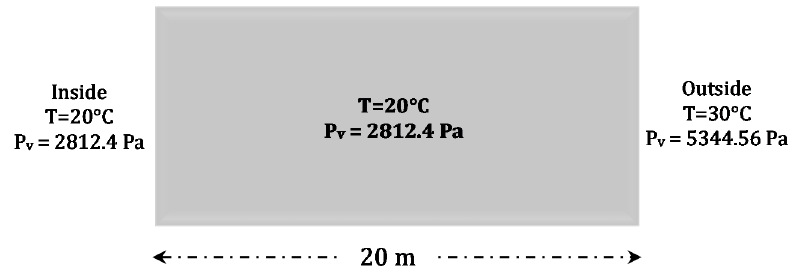
Figure 1. Initial and boundary conditions of the model.